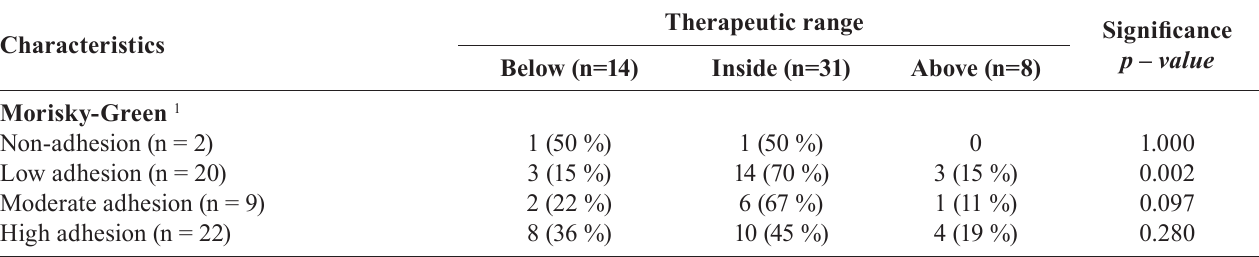
TABLE IV - Distribution of the classified fluoxetine users according to their adherence level (using Morisky-Green and BMQ classifications) and therapeutic range (FLU + NFLU)